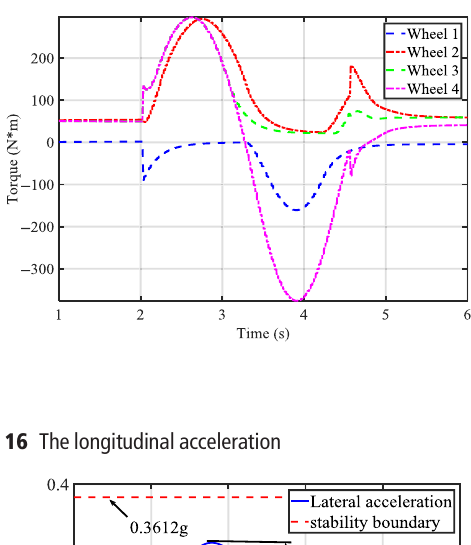
Figure 15 The torque inputs in D-EECA